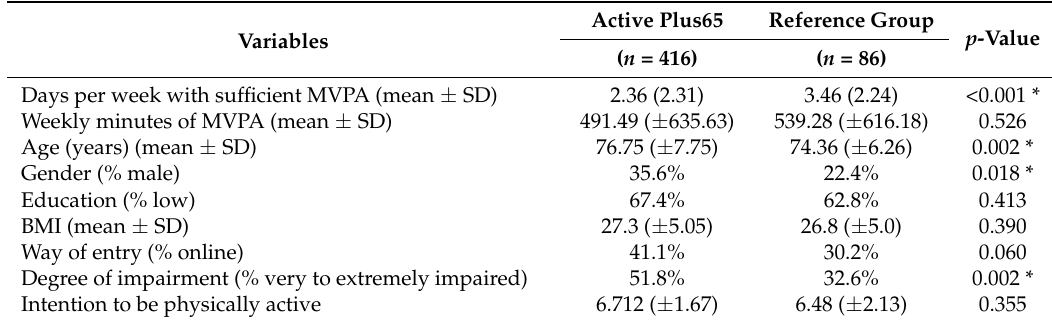
Table 1. Baseline characteristics of the research